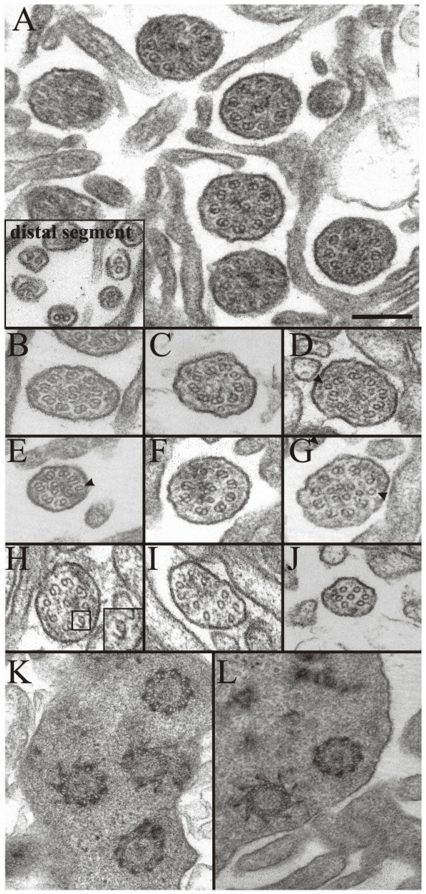
Mutant cilia showed altered microtubule organization.A: Representative group of cilia in the control sections with the
characteristic 9+2 organization of microtubules. The insert shows
the distal segment of the cilia. B–J: Cilia from
MKS3 mutant rats showing altered microtubular
organization. B: 9+2; C: 9+0; D: (9+1)+2, an extra
singlet in the periphery (arrowhead); E: (7+1)+2; F: 8+4;
G: (9+1)+6; H: (7+1)+1; I: 11; J: 7. In some cases
the external doublet showed the circumference of one of the microtubules
to be discontinuous or “opened” (F, H insert). No
differences could be detected in basal bodies from normal (K) or mutant
(L) animals. Scale bar  = 200 nm: shown in (D) for
A–L.